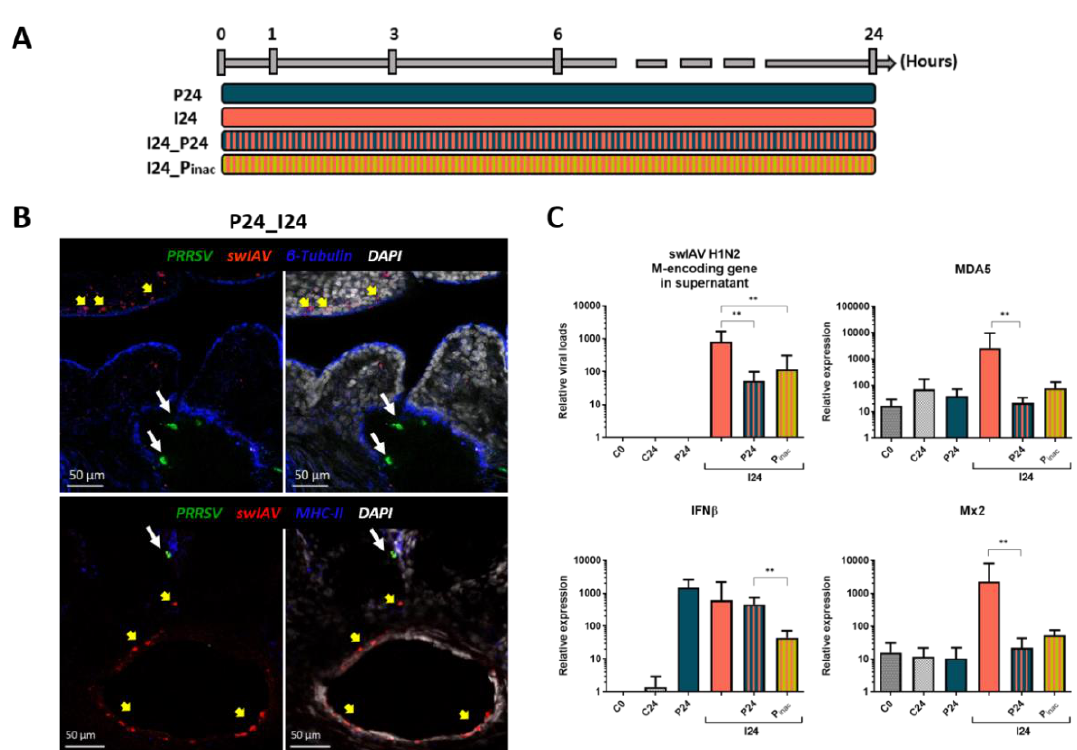
Figure 5. Protocol ( A ), immunostaining ( B ), and relative viral loads and relative expression of cellular transcripts ( C ) of the different conditions in precision-cut lung slices (PCLS) showing the impact of live and inactivated PRRSV-1 on swIAV replication and cell response. PCLS were coinfected with 10 5 particles of swIAV H1N2 and/or 10 5 particles of live or inactivated PRRSV-1. After 24 h, PCLS were fixed and stained with an antibody against viral N protein to detect PRRSV-1 particles (in green) and PRRSV-1 infected cells (white arrows) and an anti-nucleoprotein polyclonal antibody to detect swIAV H1N2 (in red) and infected cells (yellow arrows). Anti-beta-tubulin monoclonal antibody was used for epithelial ciliated cells staining while anti-MHC-II antibody was used for macrophages and other MHC-II presenting cells staining (in blue). Cell nuclei were stained (in white) using 4′,6′-diamidino-2-phenylindole (DAPI). Images were generated using a laser-scanning confocal microscope. n = 10 slices per condition for qPCR. C0 and C24 stand for the non-infected conditions over 0 h and 24 h respectively, P24 stands for PRRSV-1 infection over 24 h, I24 for swIAV H1N2 infection over 24 h, I24_P24 and I24_Pinac for the coinfection with both viruses over 24 h using active and inactivated PRRSV-1 respectively. Mean values and standard deviations are represented. Comparisons were carried out using a one-way ANOVA test and Tukey’s post-test after sorting the data by rank. Di ff erences were considered significant when p < 0.05 (*) or p < 0.01